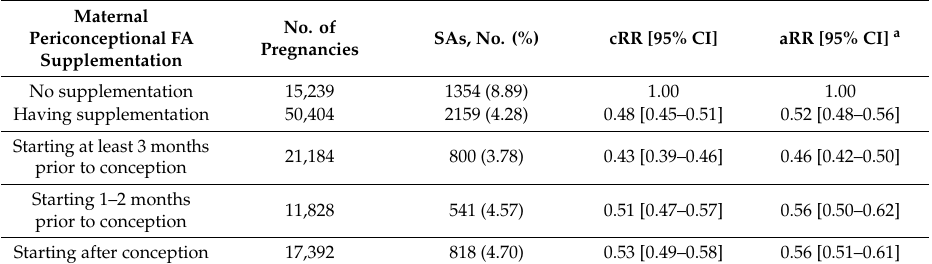
Table 2. Risk ratios and 95 CIs for spontaneous abortion (SA) according to maternal periconceptional folic acid (FA) supplementation.